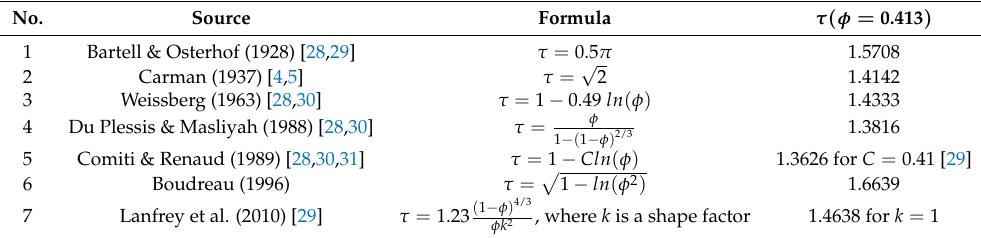
Table 1. Examples of empirical formulas serving to calculate the tortuosity for packed